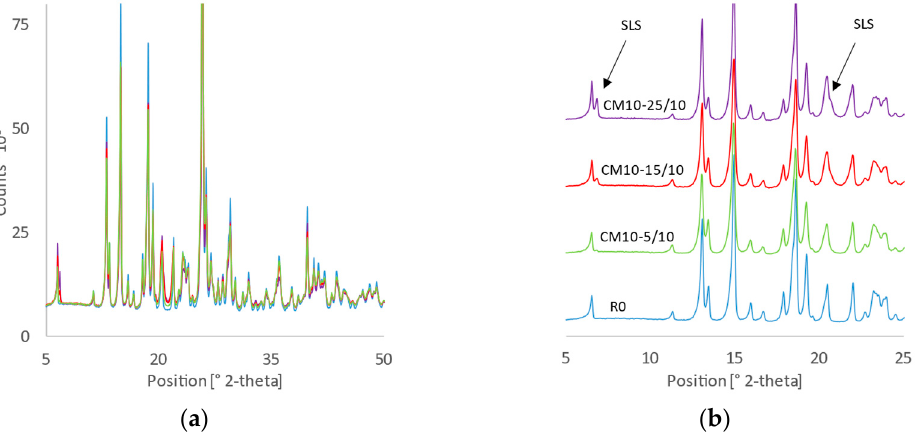
Figure 4. X-ray diffraction patterns ( a ) of reference MLX (R0-blue) and co-milled mixtures with in- creasing SLS content (CM10-5/10-green; CM10-15/10-red; CM10-25/10-purple); with offset ( b ).